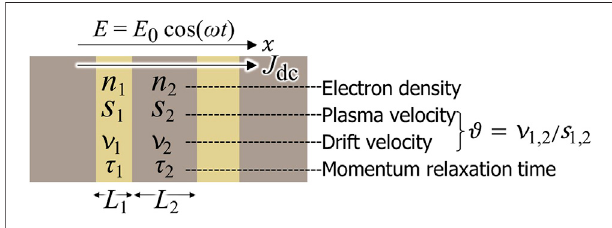
FIGURE 5 | A simpli fi ed 1D hydrodynamic modeling for the DGG structure driven by dc current in the oscillating fi eld of the THz radiation E